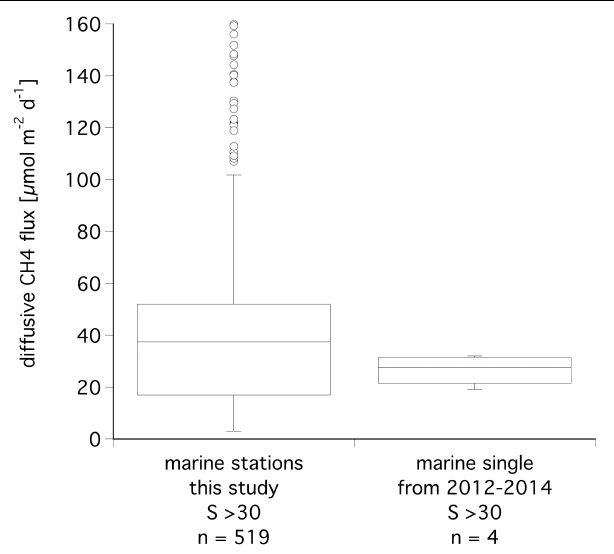
FIGURE 7 | Range of data on diffusive methane flux at marine stations from this study and from previous years. The boxes enclose 50% of the data, the median is shown as a line. The upper and lower limit of the box (upper and lower quartile, UQ, LQ) indicate values which are halfway between the median and the largest/smallest data value. The difference between these limits is defined as IQD. Outliers are defined as values which are > UQ + (1.5 * IQD) or < LQ + (1.5 *